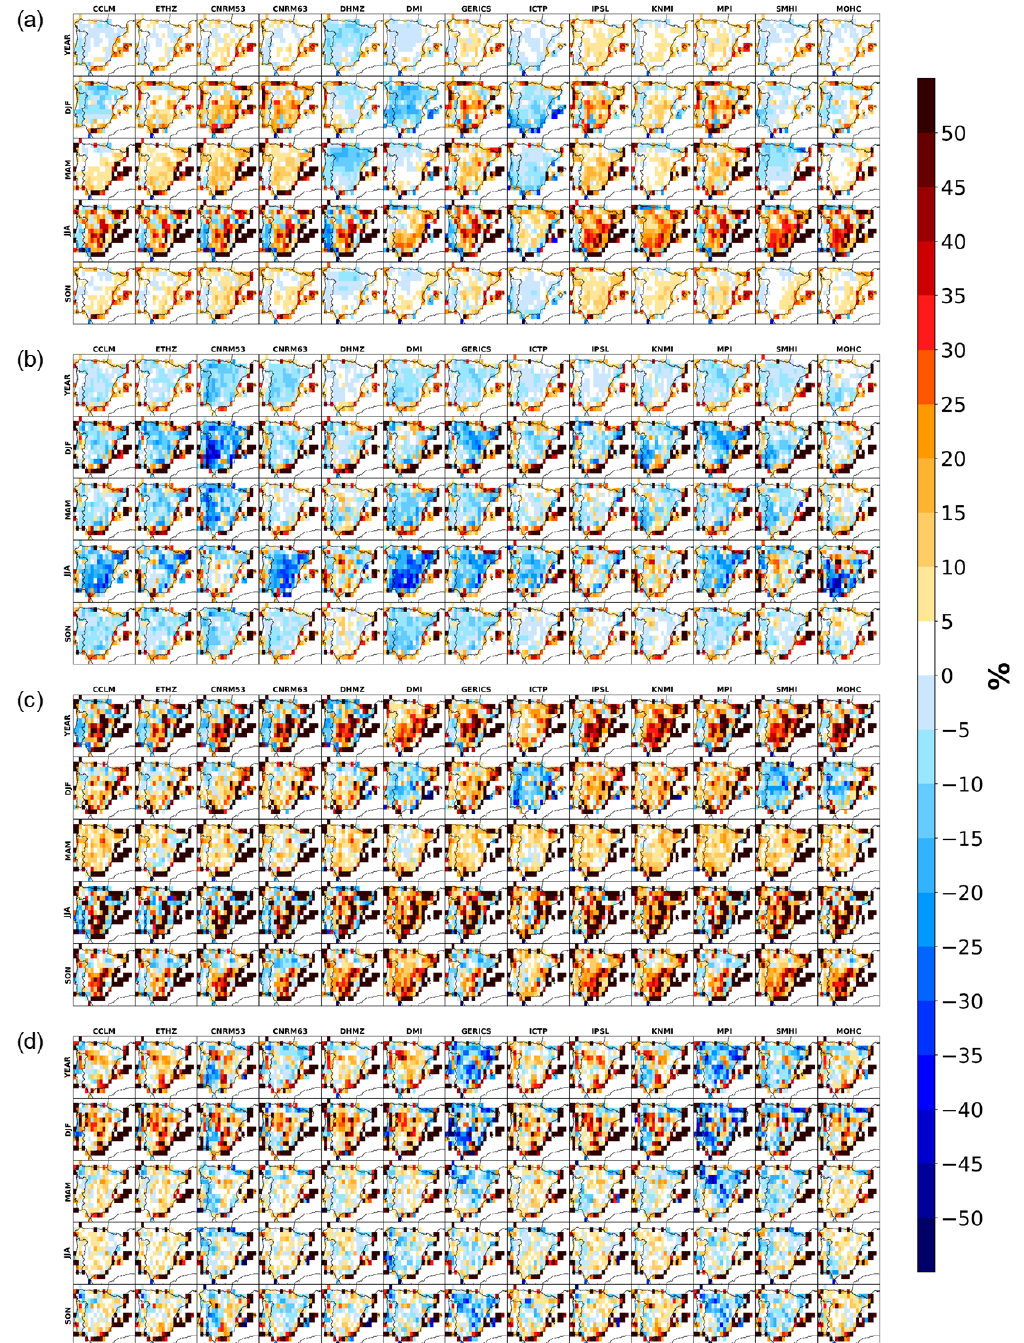
Figure 3. Yearly and seasonal spatial distribution added values (DAVs) of the Iberian Peninsula between the RCMs and the ERA-Interim reanalysis for the 1989–2008 period taken from the hindcast EURO-CORDEX simulations, with the IGD regular dataset as a reference for (a) maximum daily temperature considering the whole PDF, (b) minimum daily temperature considering the whole PDF, (c) maximum daily temperature extremes only considering the values above the observational 90th percentile from maximum temperatures for each ERA-Interim grid point, and (d) minimum daily temperature extremes only considering the values below the observational 10th percentile from minimum temperatures for each ERA-Interim grid point. All RCM data were previously interpolated to 0.1 ◦ regular resolution from the observations, while the observations were interpolated into the ERA-Interim